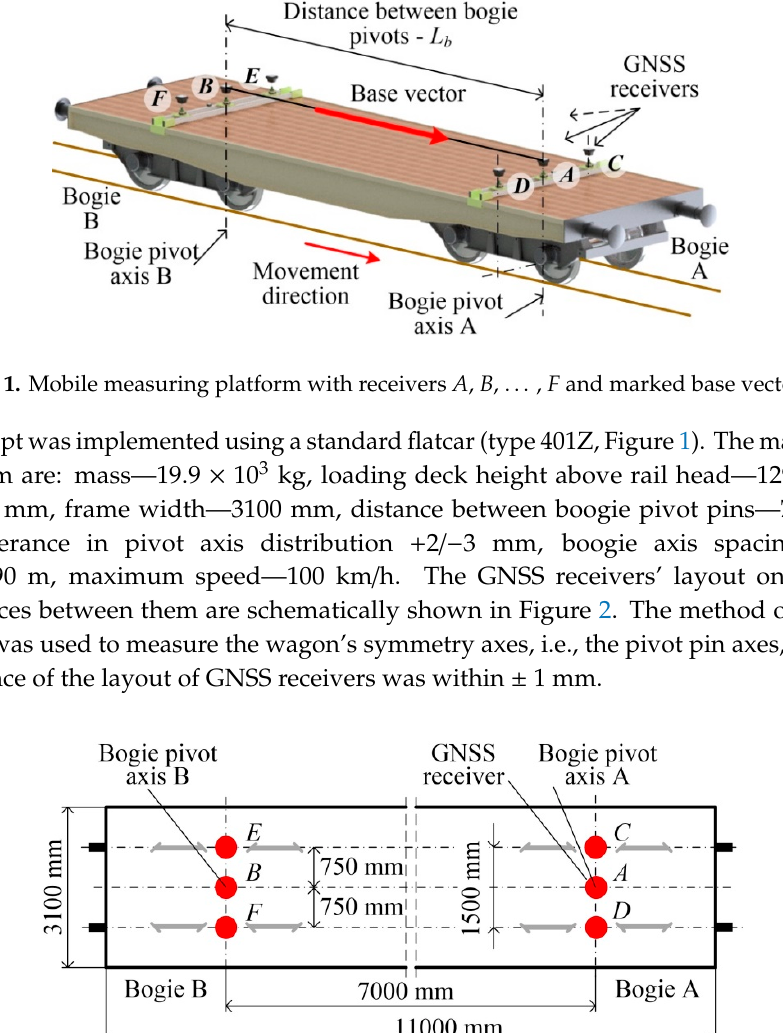
Figure 2. Layout of GNSS receivers A , B , …, F on measuring platform.